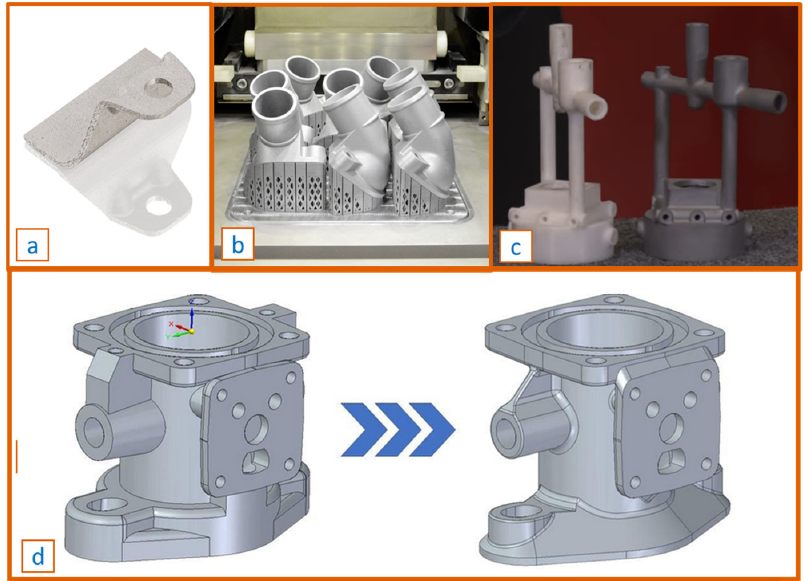
Figure A2. Metal spare-part reconstruction based on direct AM processes: ( a ) Porsche 356 B/C bracket (photo credits: Porsche Classic 3D printing, 2018, Porsche AG). ( b ) Mercedes Unimog thermostat